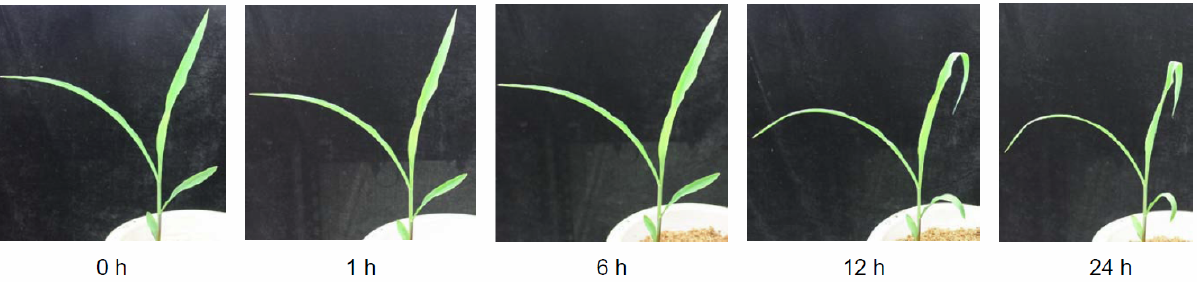
Figure 2. Effects of Cr stress on maize morphology. Maize seedlings were watered with